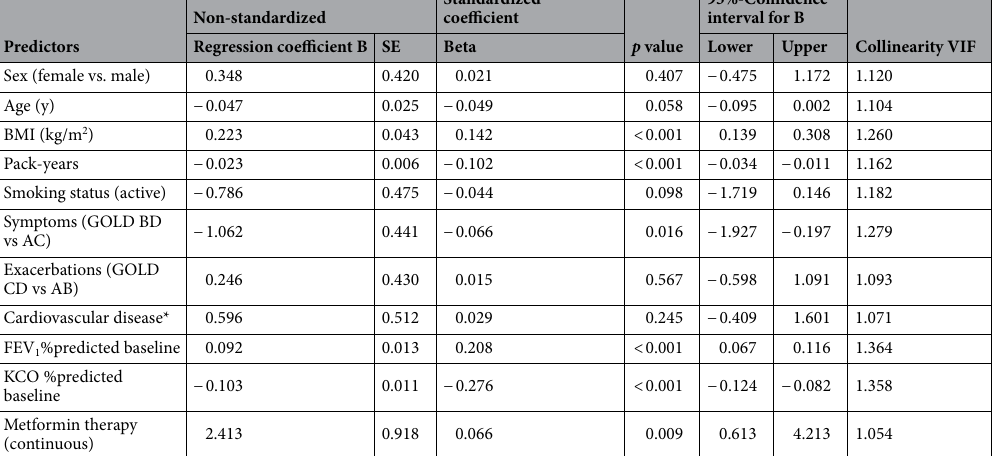
Table 2. Association between annual decline of KCO %predicted and metformin monotherapy. The table shows the results of multivariate linear regression analysis in terms of the non-standardized regression coefficients, their standard errors (SE), and 95%-confidence intervals, and the standardized coefficients. All clinical and functional indices refer to baseline (visit 1), the change of KCO to that between baseline and each patient’s last visit, expressed as %predicted at baseline. Additionally, the Variance Inflation Factor (VIF) from the collinearity diagnostics in SPSS is given, indicating that there was no problem with collinearity as all values were close to 1. *The diagnosis of cardiovascular disease comprised heart failure, coronary artery disease and myocardial